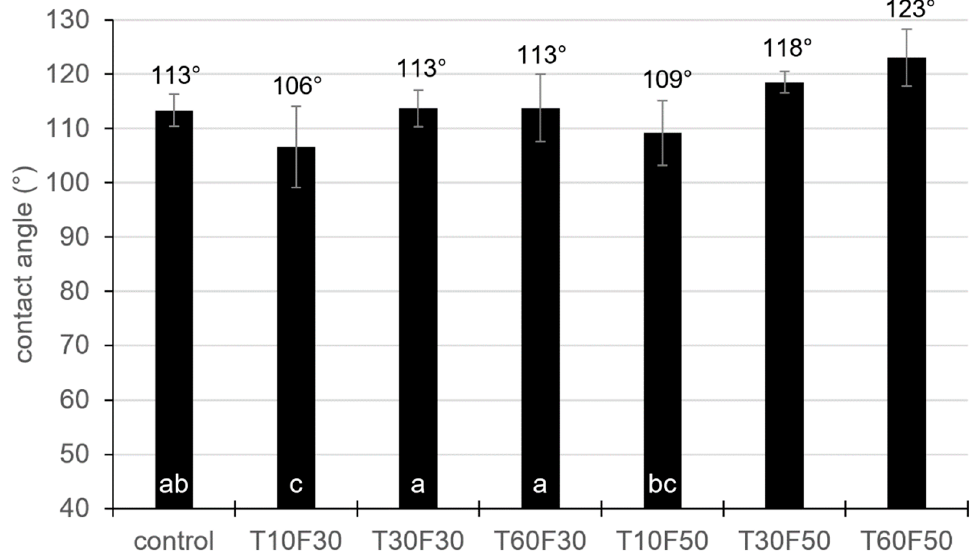
Figure 2. Effect of APD treatment on water contact angle on the surface of the pea seeds (the same letter signs the variants that are not significantly different; vertical lines denote standard deviation bars).